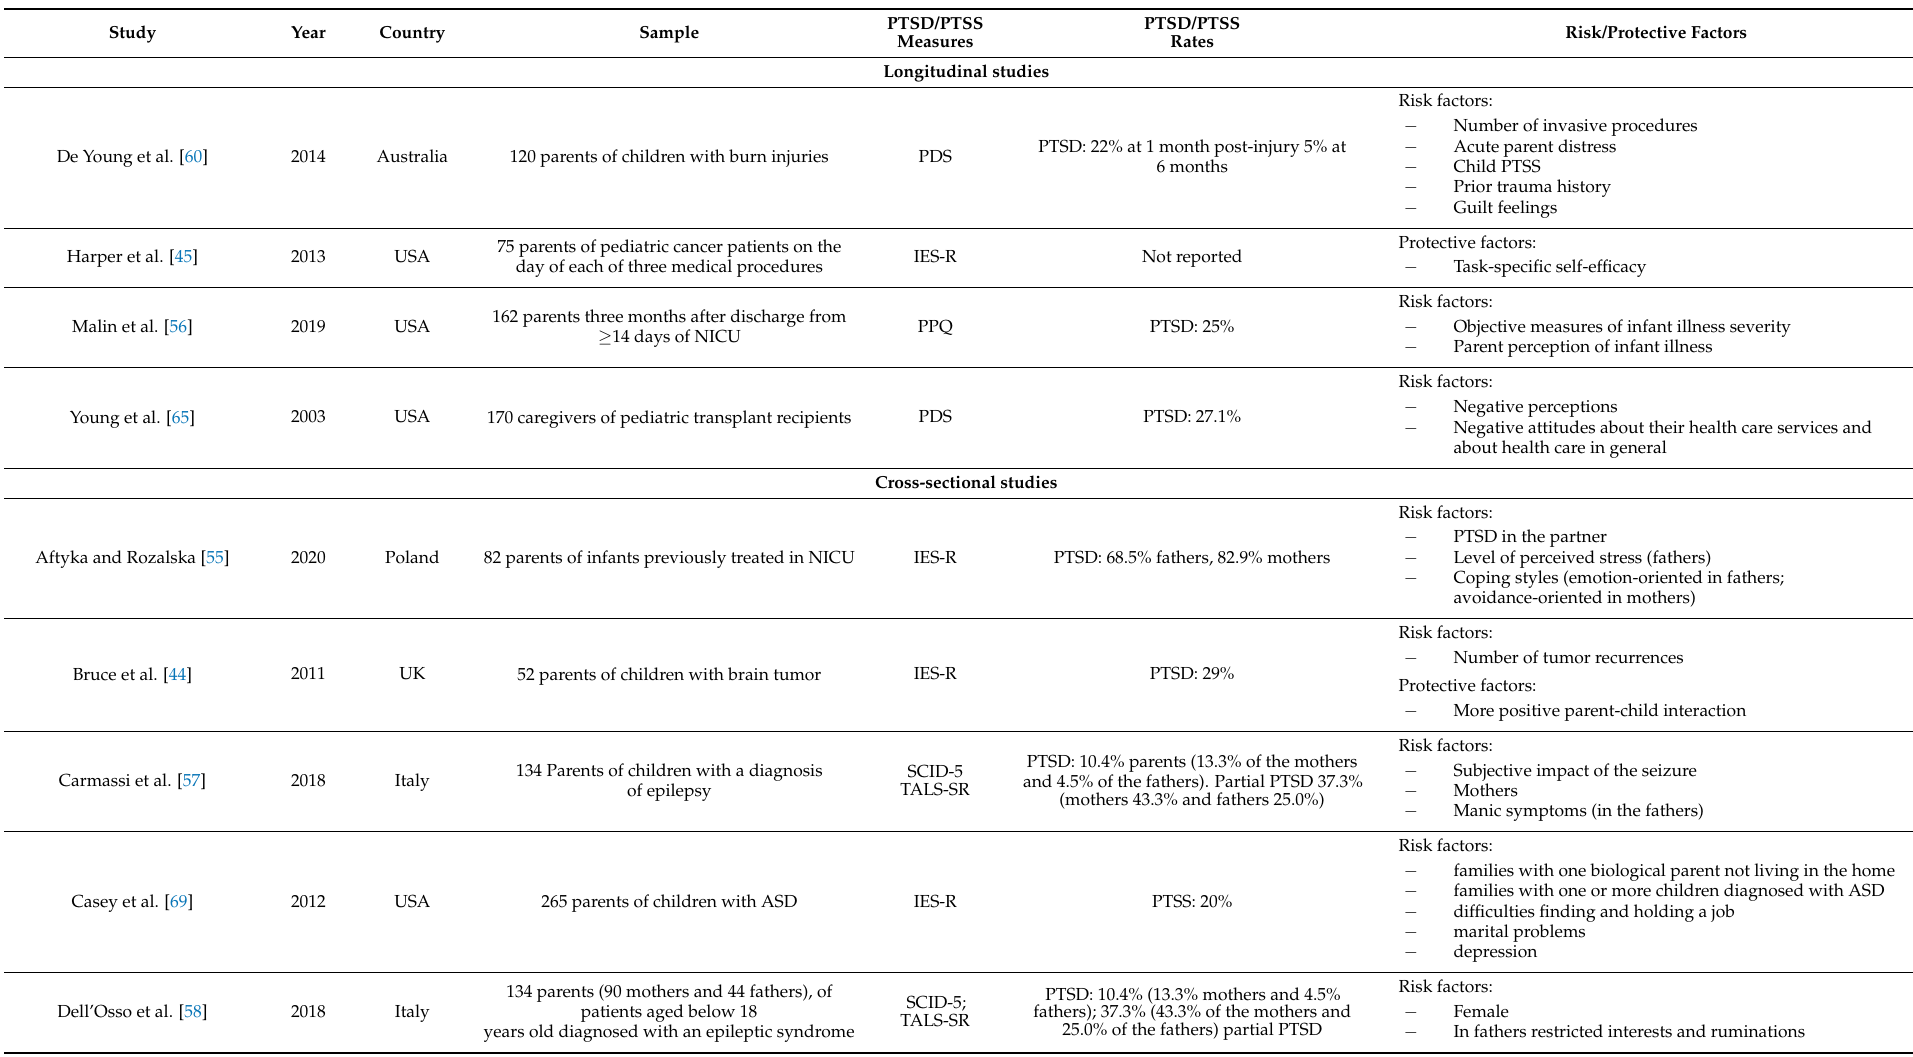
Table 1. Characteristics of the reviewed studies divided by study